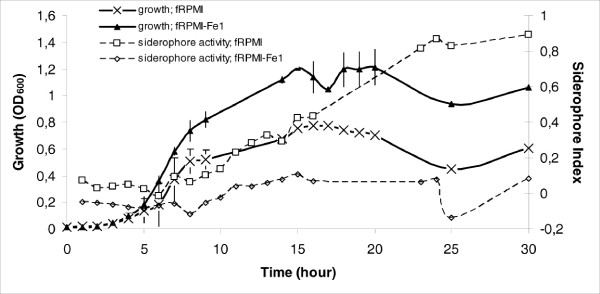
Growth kinetics and siderophore production of S. epidermidis (planktonic growth) in fRPMI and fRPMI-Fe1. Bacteria were overnight pre-incubated in fRPMI and incubated in fRPMI or in fRPMI-Fe1. The right y-axis, the dotted line with empty diamonds (fRPMI-Fe1) and the dotted line with empty squares (fRPMI) represent siderophore activity, measured at 630 nm. The left y-axis, the full line with filled triangles (fRPMI-Fe1) and the full line with crosses (fRPMI) represent the growth curve, given as OD600. The x-axis contains the time in hours. The line that links the data points helps to clarify the results at each time point measured. The error bars represent standard deviations. At each time point 15 samples from three independent cultures (five samples from each culture) were assessed.